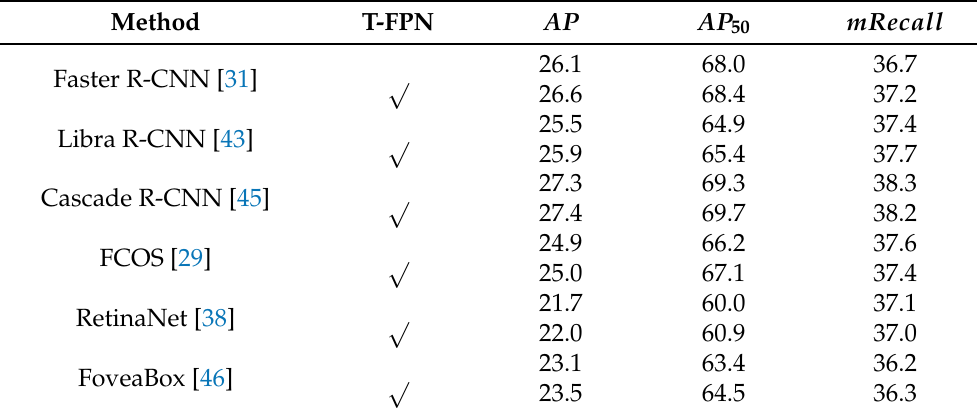
Table 4. The performance of various detection methods with or without T-FPN.